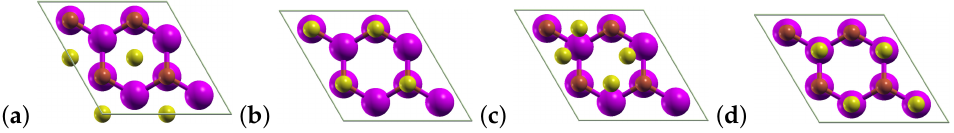
Figure 2. Adsorption sites indicated by yellow balls and defined in a 2 × 2 lateral unit cell representing GaN ( 000¯1 ) (N-terminated N-face). ( a ) H3. ( b ) On top. ( c ) Bridge. ( d ) T4.